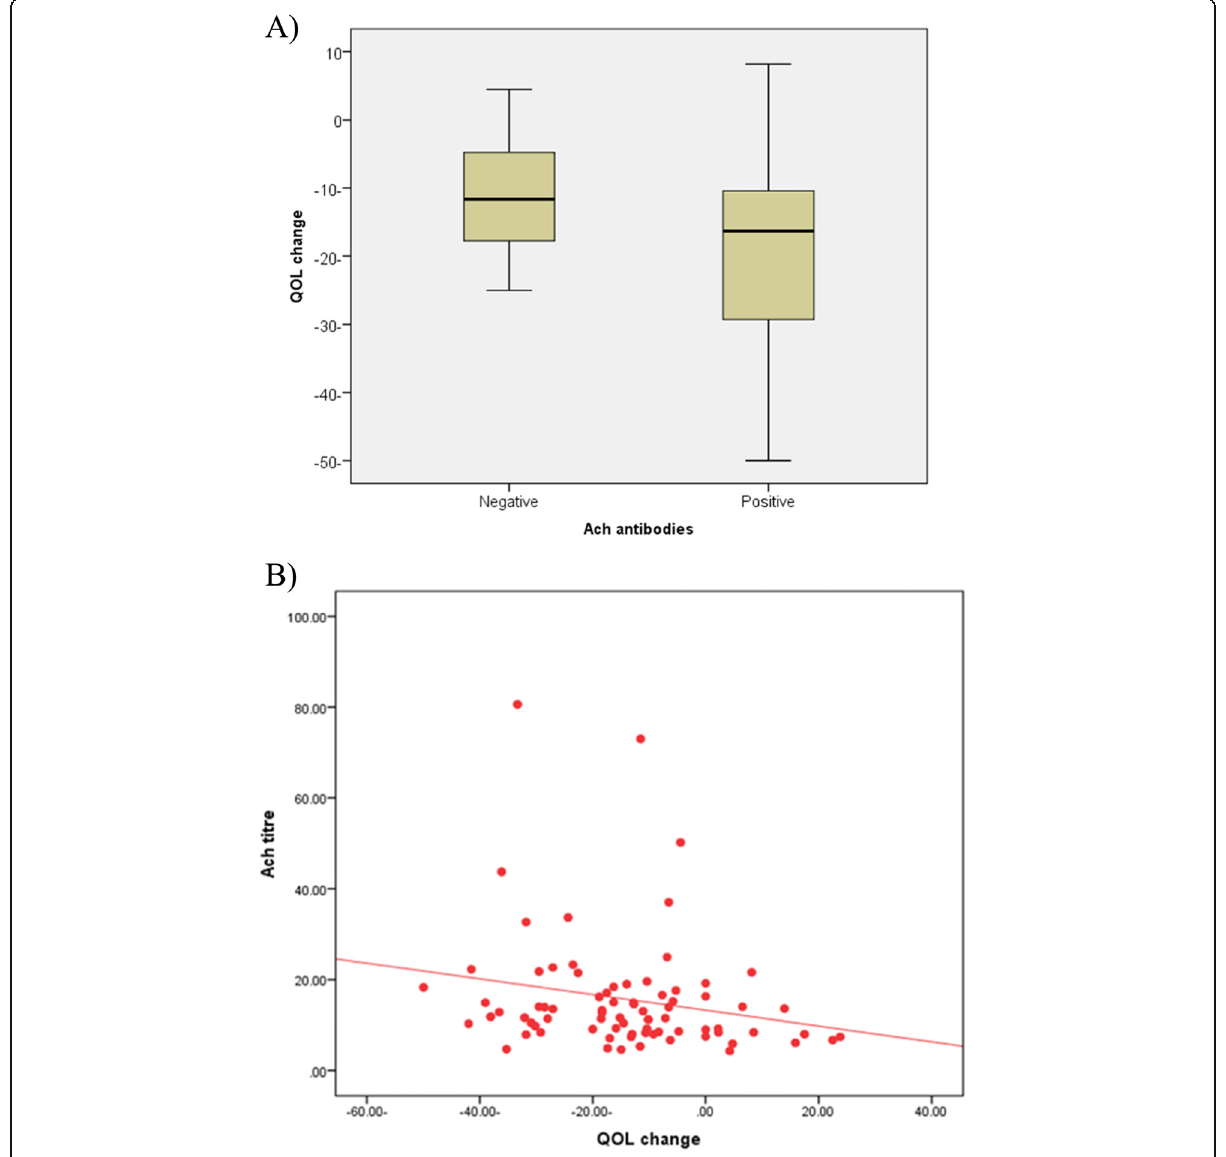
Fig. 2 Correlation between presence of AchR antibodies and antibody titer with QOL scores after plasmapheresis Table 4 Correlation between AchR antibodies titer of the studied patients and studied scores AchR titer r P value